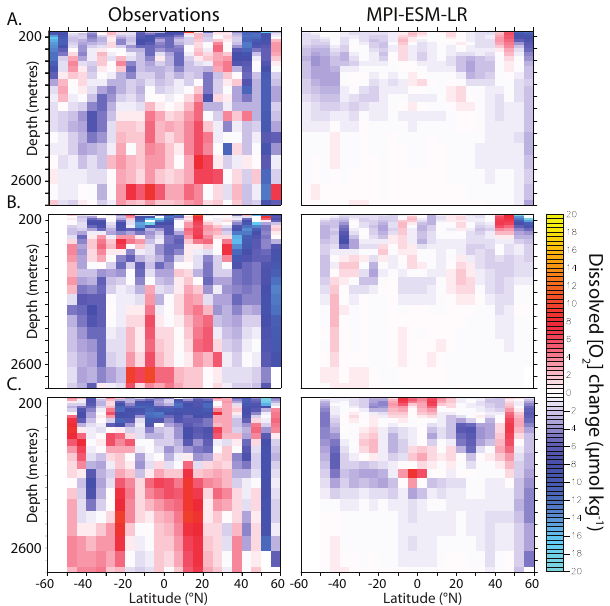
Fig. 5. Observed (left) and simulated (right) patterns provided to the 2-D optimal detection as zonal mean [O 2 ] changes (µmolkg − 1 ) as a function of latitude and depth for the global ocean (60 ◦ S–60 ◦ N; A ), and for the Pacific (B) and Atlantic (C) ocean basins. Masked MPI-ESM-LR [O 2 ] fields and observations are interpolated onto a ∼ 5 ◦ latitude by ∼ 10 ◦ longitude grid with 40 unevenly spaced depth levels and zonally averaged.